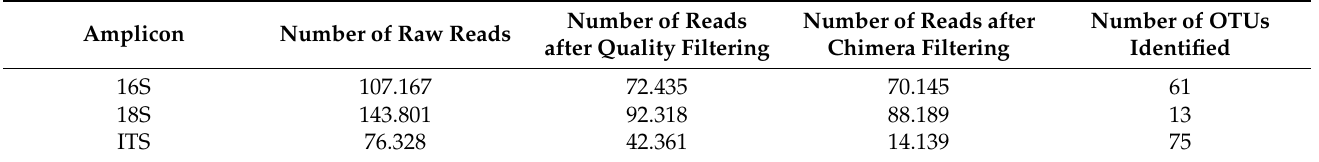
Table 1. Number of raw and quality filtered reads, number of sequences after chimera removal, and number of identified operational taxonomic units (OTUs) for 16S rRNA, 18S rRNA, and internal transcribed spacer (ITS) amplicon sequencing.